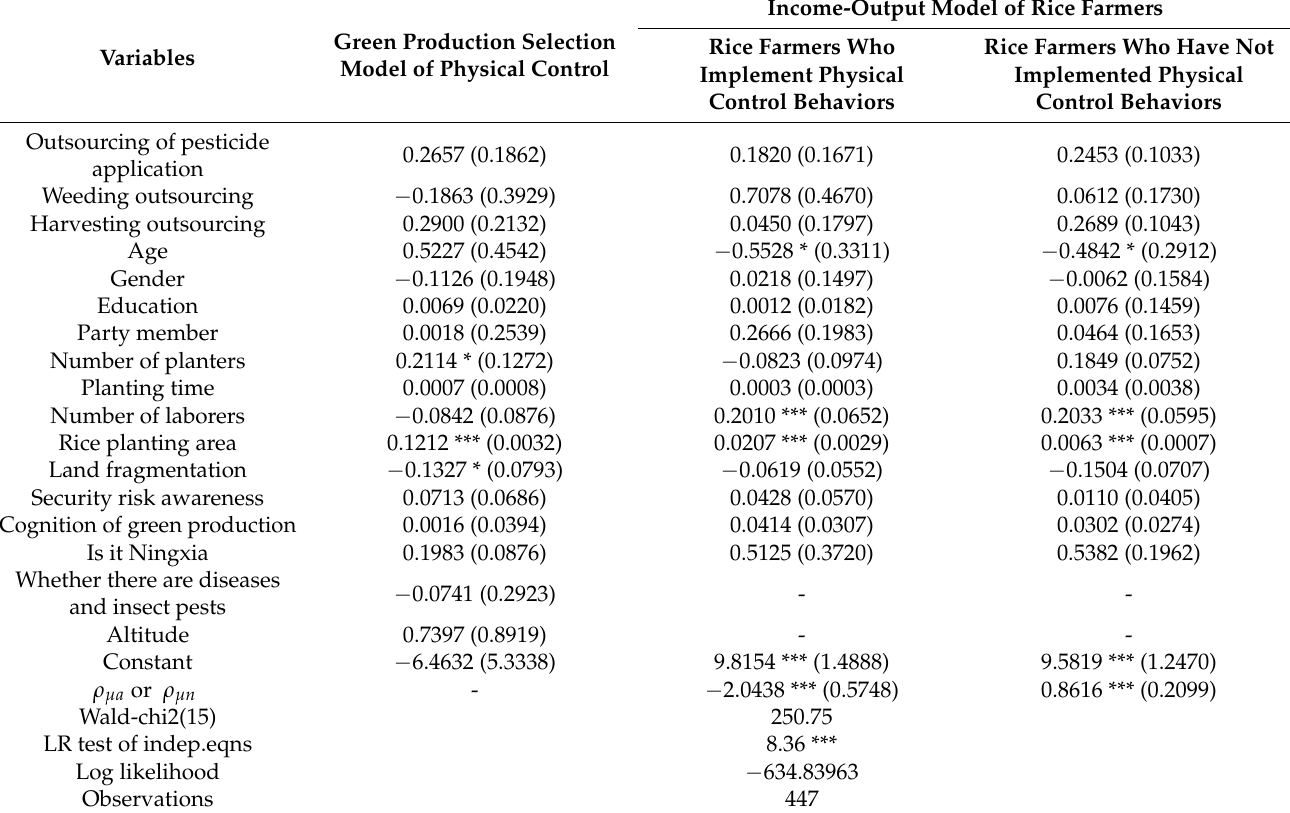
Table 9. Simultaneous estimation results of green production behaviors model and rice income-output model using physical control